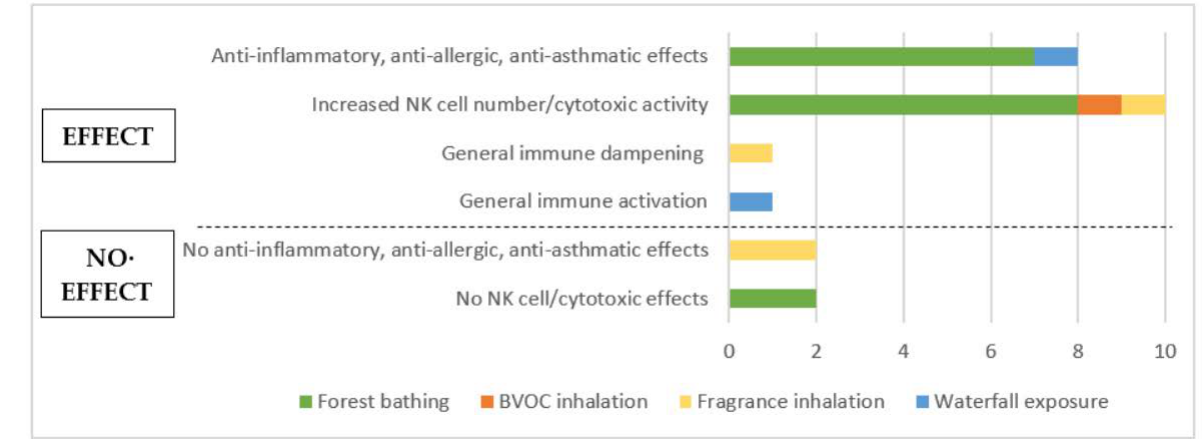
Figure 2. Overview of outcomes from human